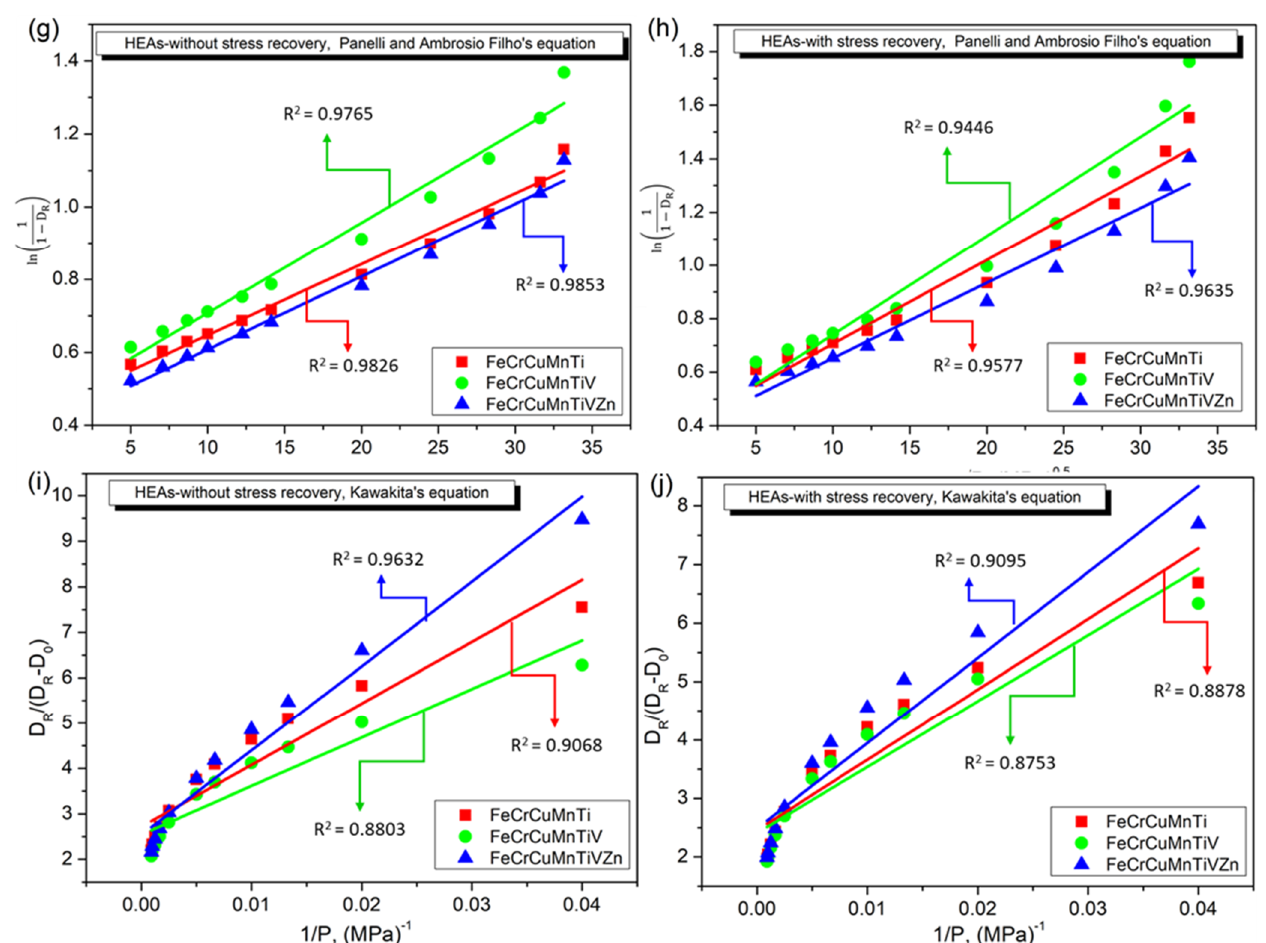
Figure 11. Densification behavior fitted by various linear models for the three developed nanostructured HEAs for as-milled and stress recovered conditions: ( a , b ) Balshin’s Equation (6); ( c , d ) Heckel’s Equation (7); ( e , f ) Ge’s Equation (8); ( g , h ) Panelli and Ambrosio Filho’s Equation (9); ( i , j ) Kawakita’s Equation (10).